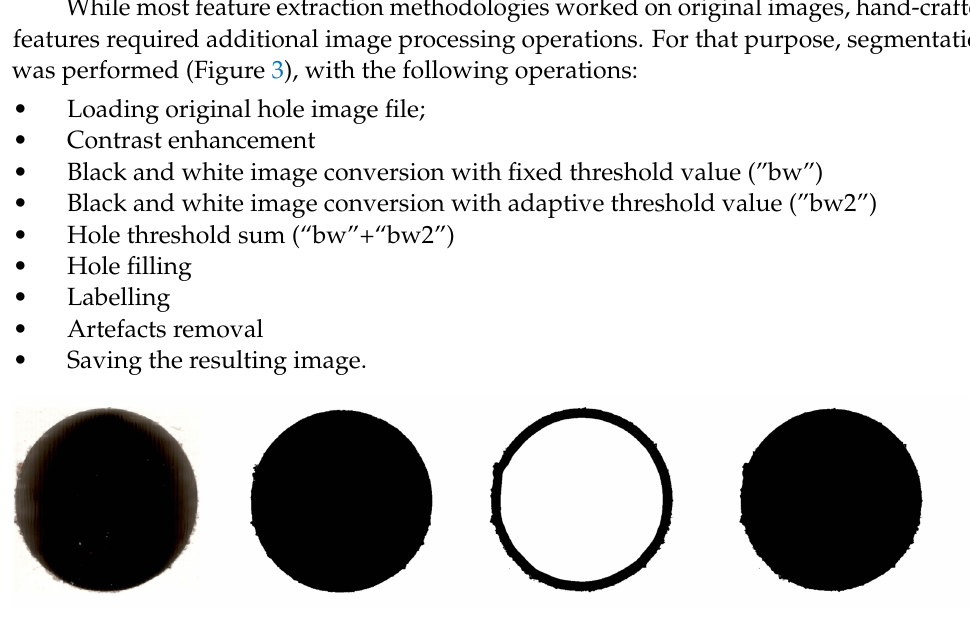
Figure 3. Steps of image segmentation for the hand crafted feature set (left to right): input scan, “bw”, “bw2”,